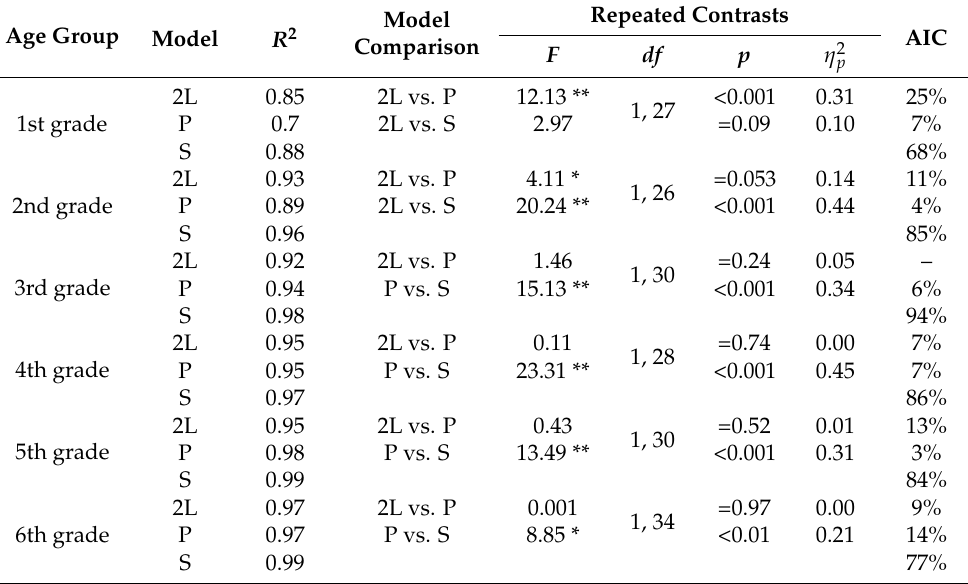
Table 2. Statistics of the various models by age group in Experiment